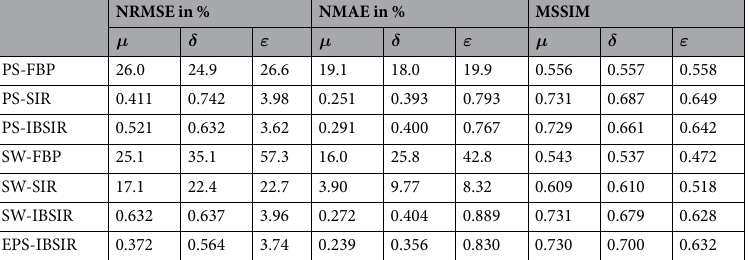
Table 1. Normalized root-mean-squared error (NRMSE), normalized mean absolute error (NMAE), and mean structural similarity (MSSIM) were separately calculated for the linear attenuation coefficient μ , refractive index decrement δ , and linear diffusion coefficient ε . PS stands for the phase-stepping simulation, SW for the sliding window simulation and SSEPS for the single-shot electromagnetic phase-stepping simulation. Reconstructions where performed using filtered backprojection (FBP), statistical iterative reconstruction (SIR) and interferogram-based SIR (IBSIR). The SIR and IBSIR approach performs better than the FBP method for all simulations, whereas superior behavior of IBSIR over SIR can only be claimed for the SW